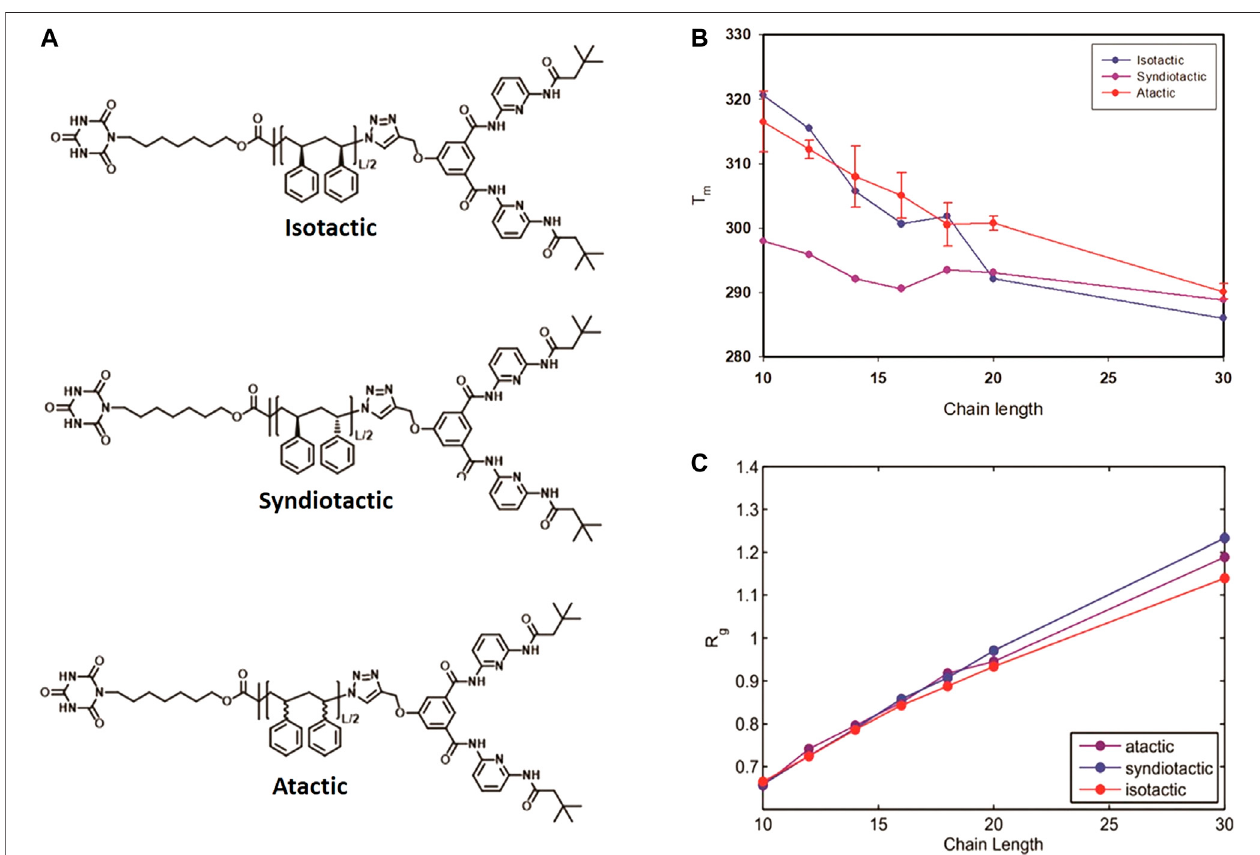
FIGURE10| MolecularstructureofIsotactic,Syndiotacticandatacticpolymers (A) ,Foldingtemperatureasafunctionofchainlengthforisotactic,syndiotacticand atactic polymers (B) , Radius of gyration (Rg) as a function of chain length (C) , for atactic, isotactic and syndiotactic polymers (Reproduced by permission of The Royal Society of